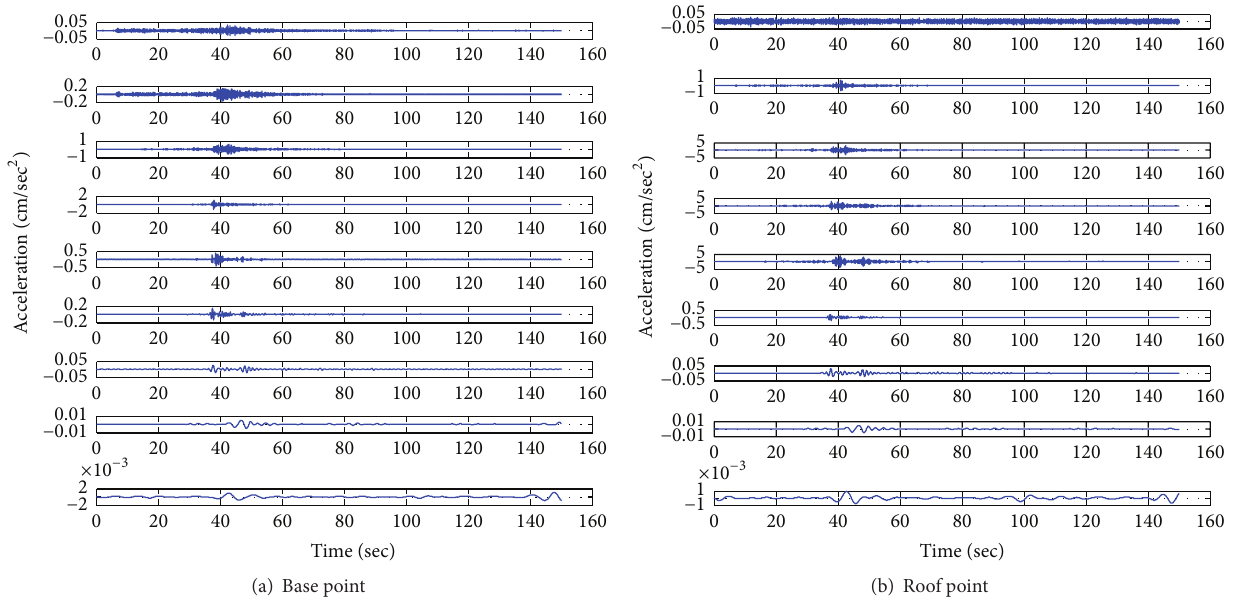
Figure 14: Decomposition levels of the reconstructed details for the base and roof points in 𝑋 direction during earthquake